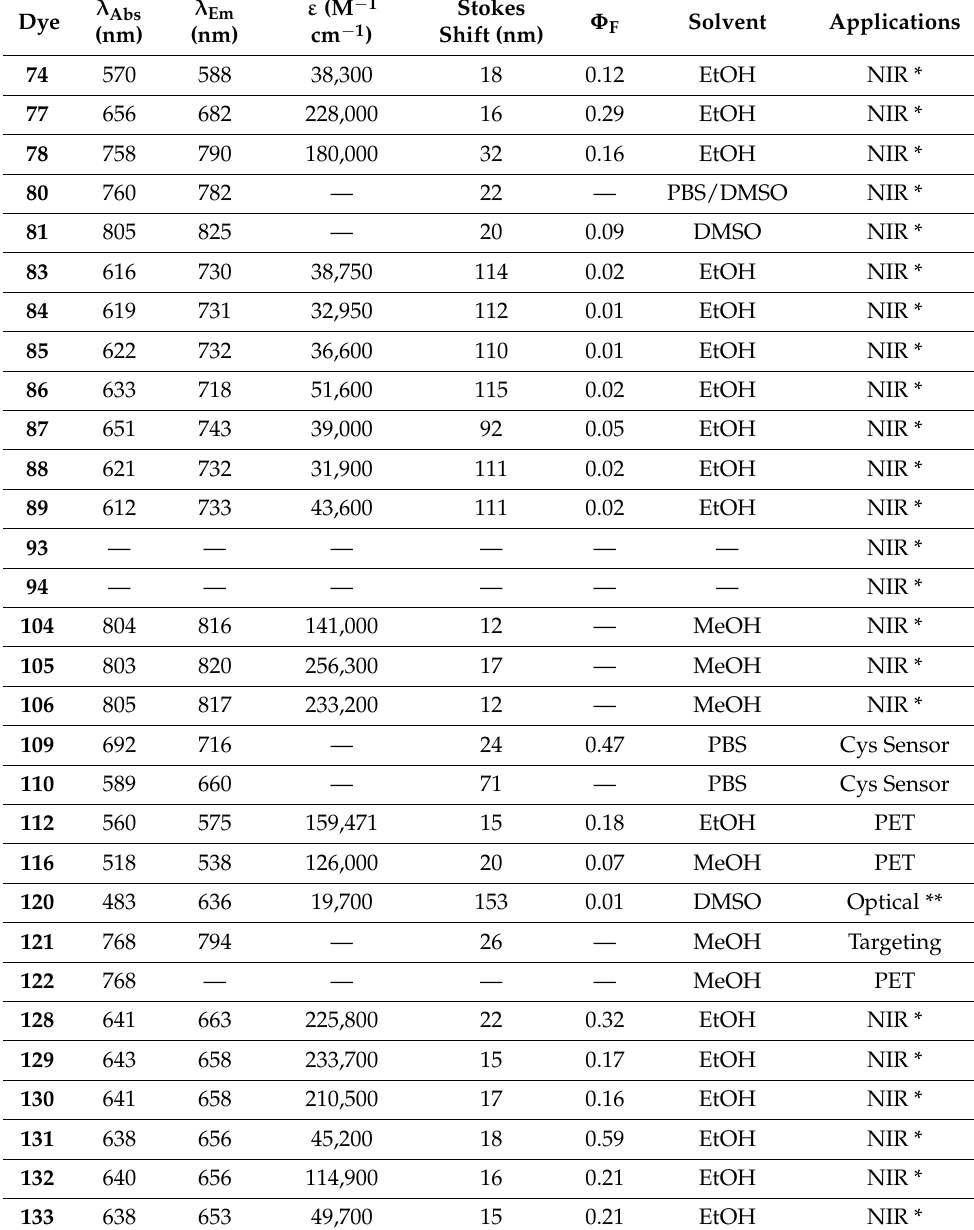
Table 4. Optical properties of selected fluorinated cyanine